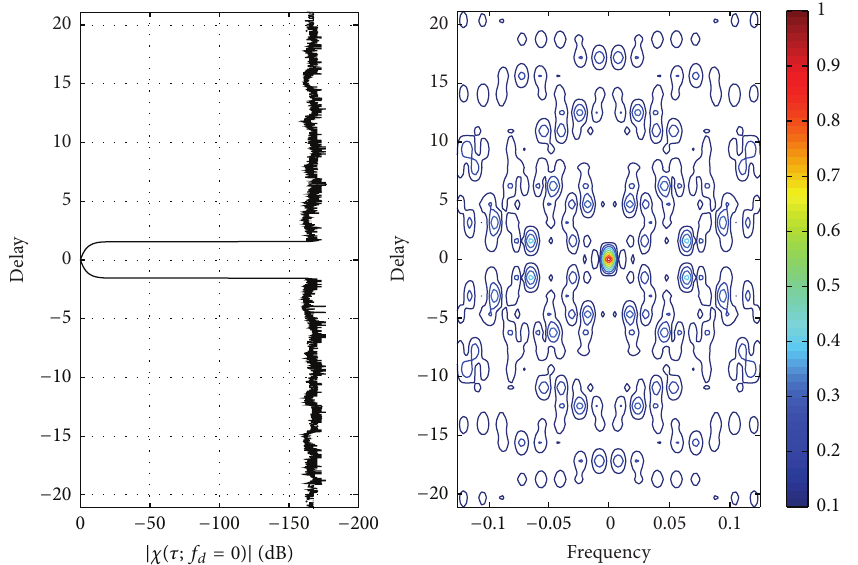
Figure 3: Ambiguity function for a 32-bit-length Golay code: contour plot and |𝜒(𝜏;𝑓 𝑑 = 0)| cut.